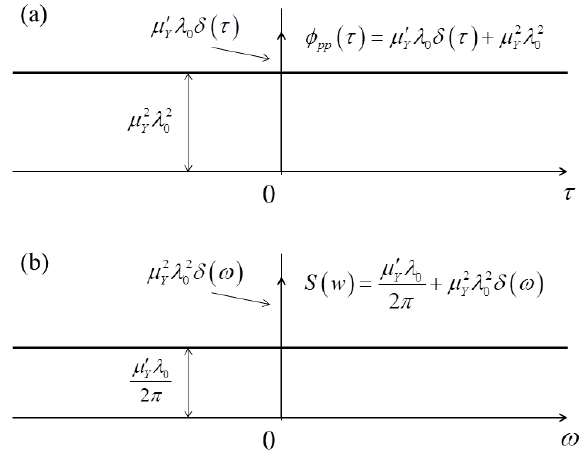
Figure 3. The statistical function of random impact load. ( a ) Auto-correlation function; ( b ) power spectral density function.